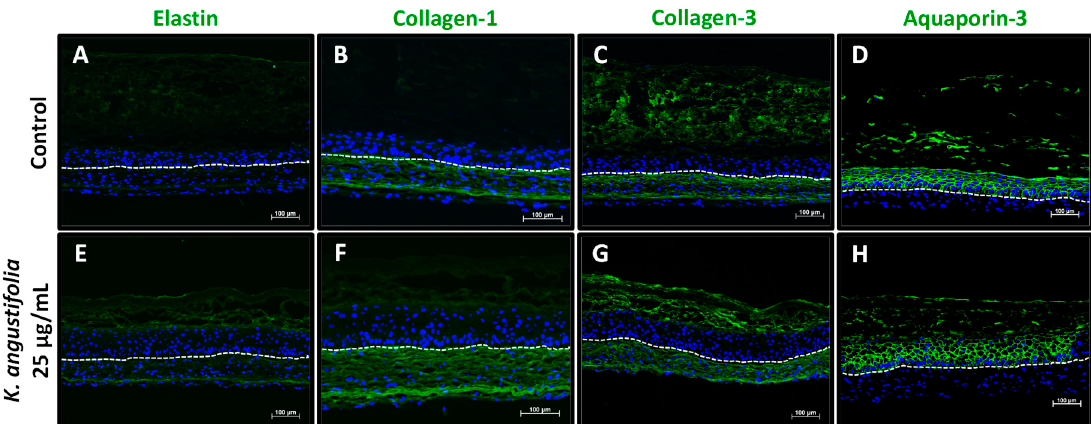
Figure 5. Aging markers visualized by immunofluorescence staining. Elastin ( A , E ), collagen-1 ( B , F ), collagen-3 ( C , G ) and aquaporin-3 ( D , H ) expression, which usually decreases during skin aging, is shown in healthy skin substitutes untreated ( A – D ) and treated with the K. angustifolia extract at 25 μ g/mL ( E – H ). The nuclei were stained with DAPI (blue). The dotted line represents the separation between the epidermis and dermis. Two substitutes for each condition were analyzed and confirmed with three different cell populations ( N = 3, n = 2; scale bar: 100 μ m).